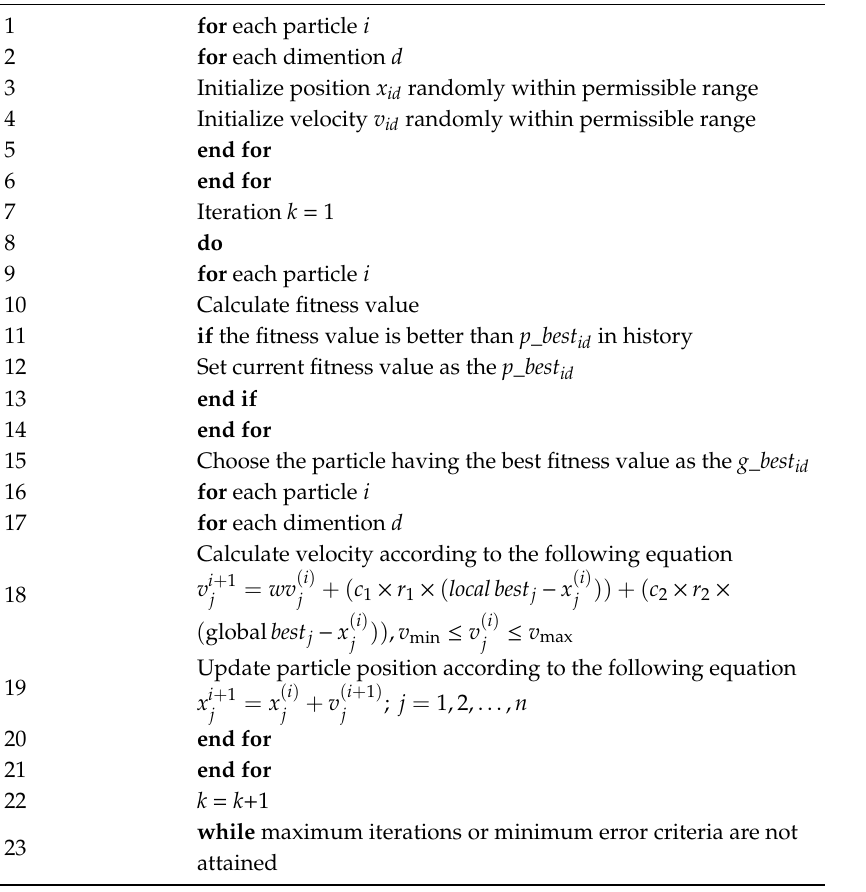
Algorithm: The particle swarm optimization (PSO) pseudo-code for the optimization